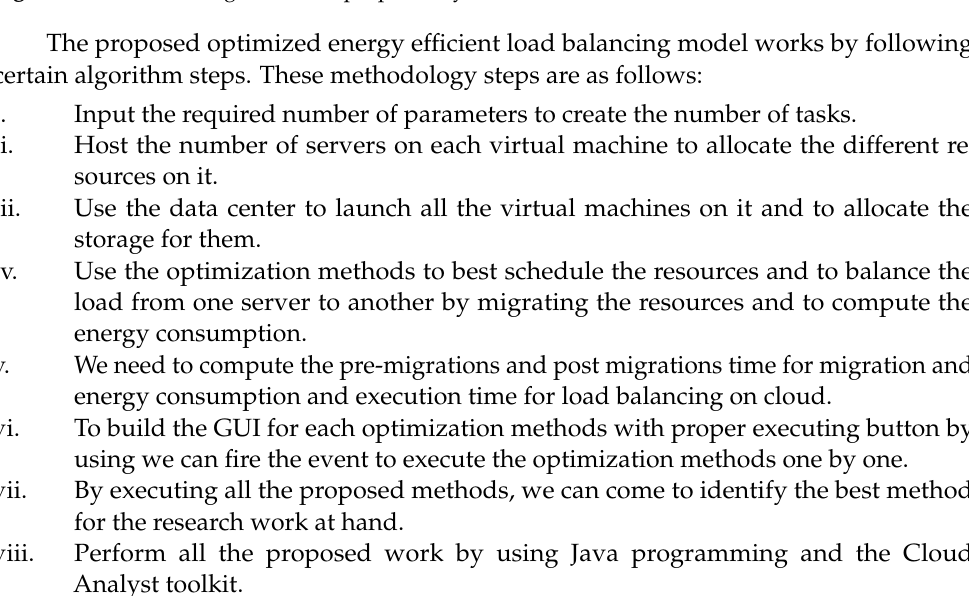
Figure 3. Workflow diagram of the proposed